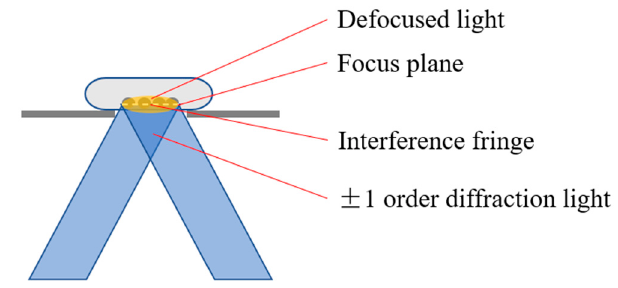
Figure 3. In the imaging process of the fluorescence inverted microscope, the ±1 order diffraction light interferes on the focal plane to generate stripe structured light and then illuminate the sample. At this time, in addition to the focal plane being excited, a small part of the defocus signal is also